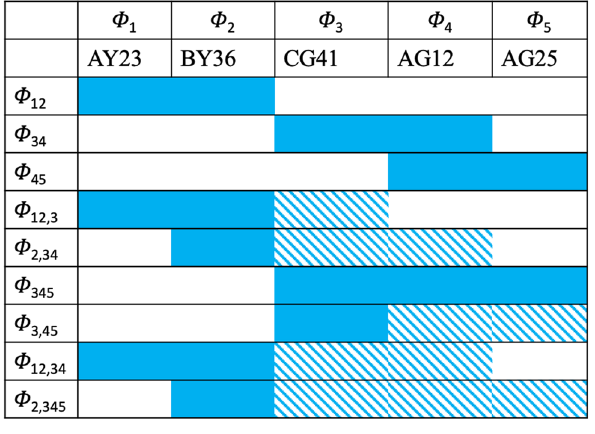
Figure 3: A visualization of all possible partitions ϕ for the instan - tiation AY 23, BY 36, CG 41, AG 12, and AG 25. A partition is indicated by successive columns in solid or striped